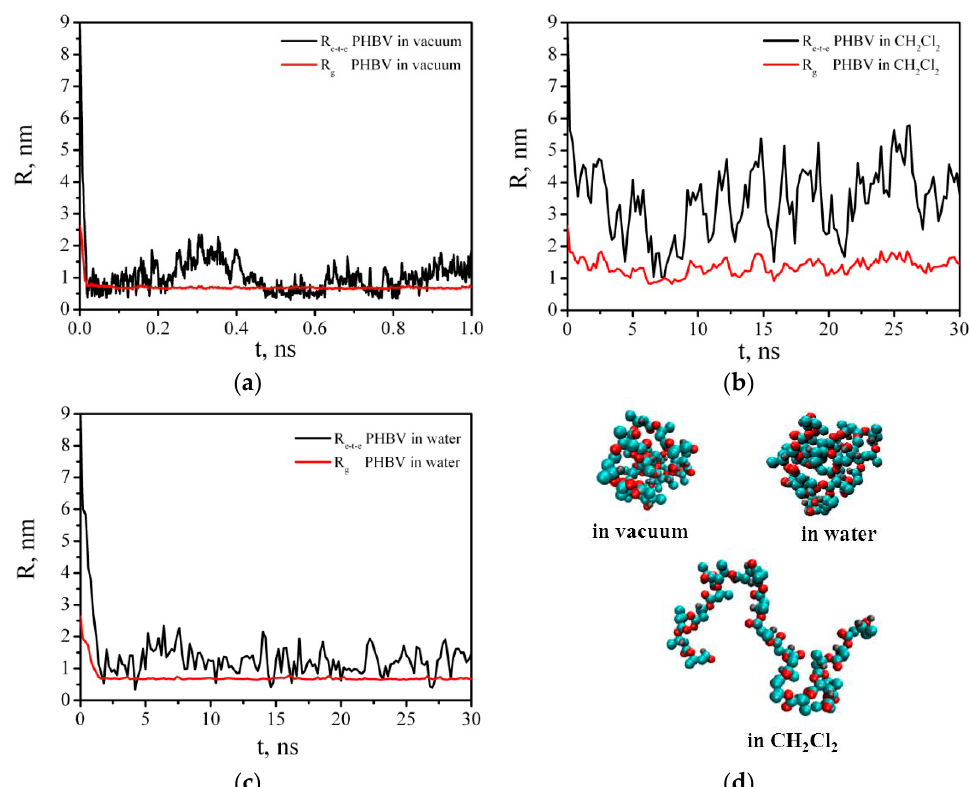
Figure 15. Time dependences of the end-to-end distance (R e-t-e ) and radius of gyration (R g ) of the PHBV in vacuum ( a ), DCM ( b ), and water ( c ); instant snapshots of the PHBV chain conformations in vacuum, DCM, and water ( d ).